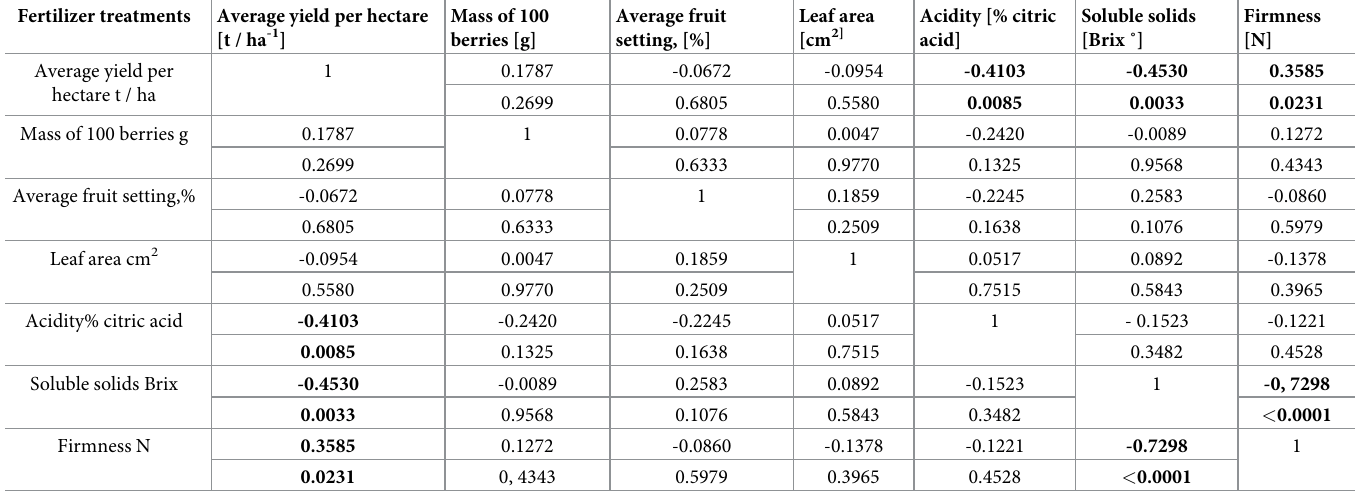
Table 5. Pearson’s correlation coefficient for the parameters of yield size and quality. Fertilizer